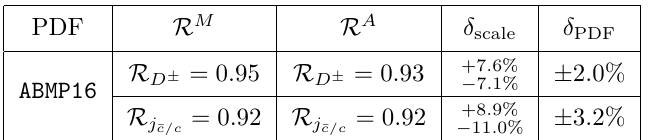
Table 5 . Our predictions for the ratios of the integrated fiducial NLO + SMC cross sections √ R = σ ( W + + D − ) /σ ( W − + D + ) and R = σ ( W + + j ¯ c ) /σ ( W − + j c ) according to the s = 7 TeV D ± j ± c ATLAS analysis of ref. [21], using either the Monash (second column) or the ATLAS A14 (third column) central tune. Also reported, for the simulations with the ATLAS A14 central tune, are the uncertainties, computed assuming no correlation between numerator and denominator, stemming from scale variation and from PDF variation within the ABMP16_3_NLO PDF